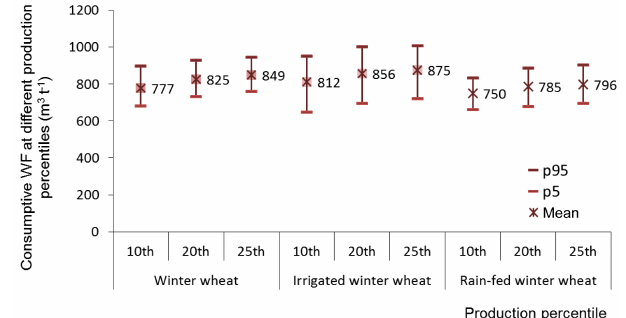
Figure 5. Benchmark levels for the consumptive water footprint (WF) of winter wheat in China at different production percentiles, considering all separate years in the period 1961–2008. Cross marks refer to the mean values; ranges refer to the 5–95% of accumulative frequencies. Figure 6. Simulated consumptive water footprints (WFs) of winter wheat, categorized into four classes (the best 10% of production, the next best 10%, the second next best 5%, and the worst 75% of production), accounting for different benchmark levels for humid vs. arid parts of China, for the year 2005 (climatic average